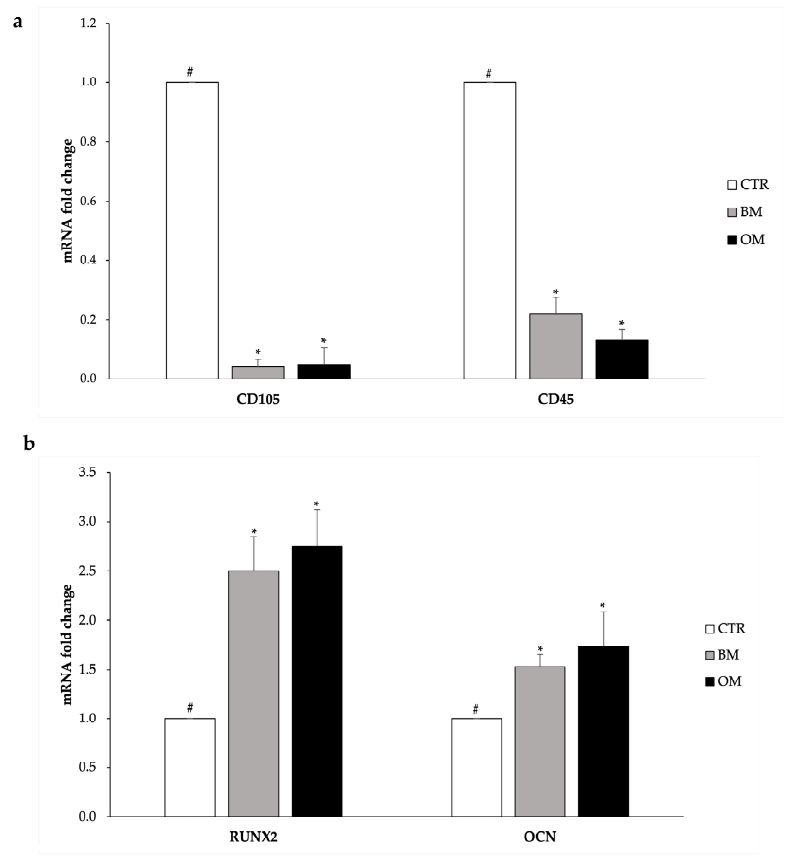
Figure 5. Analysis of the gene expression of the stemness markers ( a ) and osteogenic markers ( b ) of CGF primary cells. CTR: undifferentiated; CGF primary cells; BM: CGF primary cells grown on HA-Si scaffolds for 21 days in BM; OM: CGF primary cells grown on HA-Si scaffolds for 21 days in OM. GAPDH was used as a housekeeping gene for normalization. Results are expressed as mean ± SD of triplicate measurements from three independent experiments. Samples bearing different symbols (#, *) differ significantly ( p < 0.05).